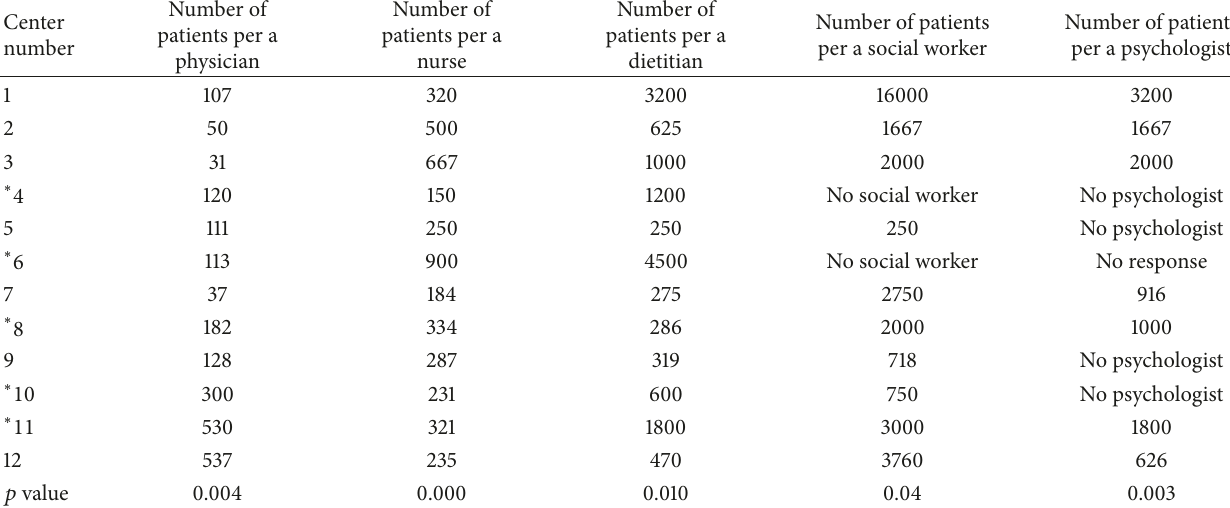
Table 3: Number of IBD patients per physicians and allied healthcare professionals in individual tertiary centres.